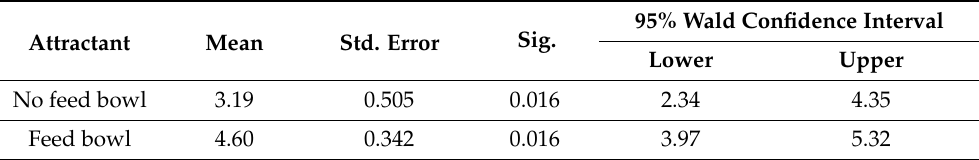
Table 5. Estimates of duration (in seconds) in the presence/absence of